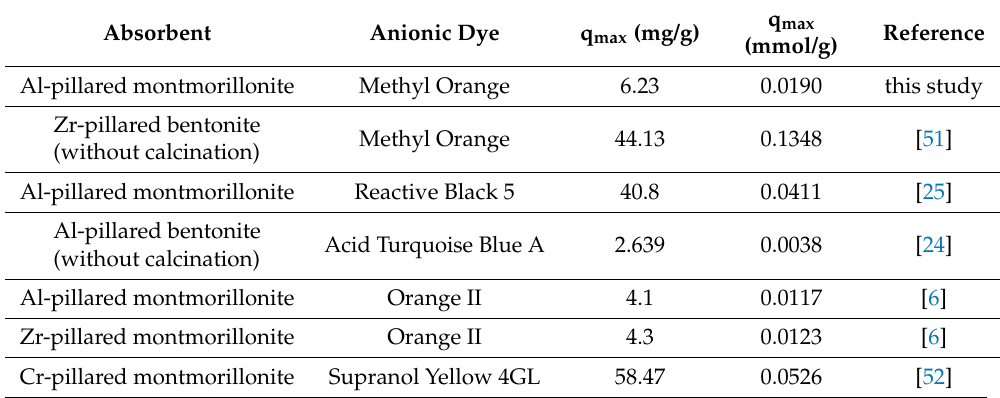
Table 6. The maximum adsorption ability of inorganic-pillared montmorillonite towards anionic dye.